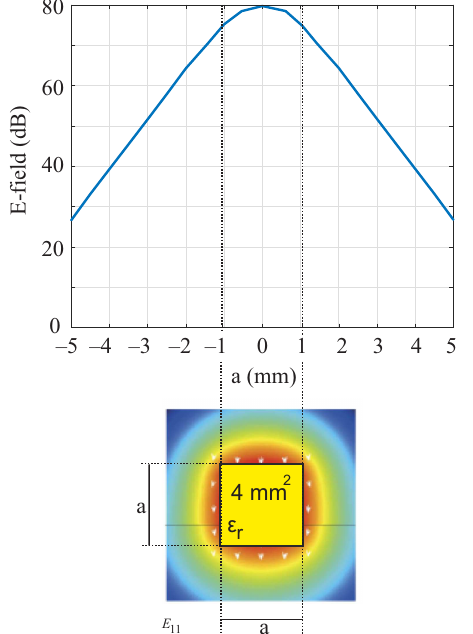
Figure 4. Simulated E-field distribution of the fundamental mode E x